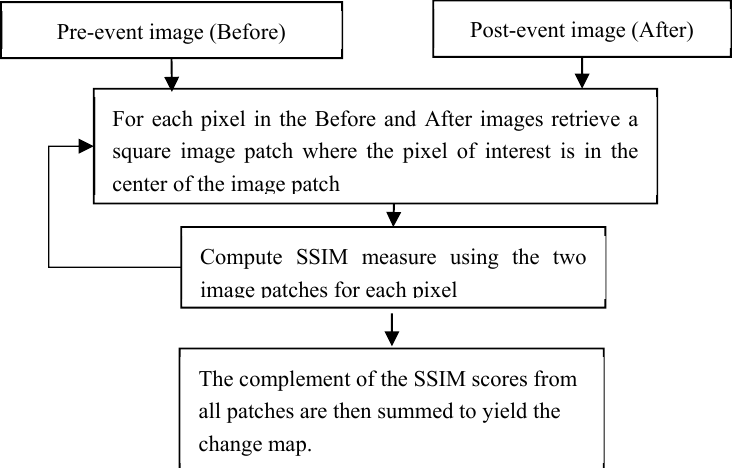
Figure 1. Block diagram for the SSIM-based change detection approach.